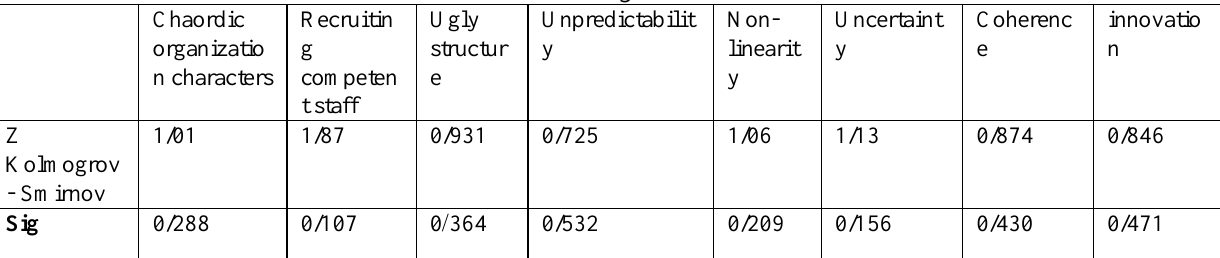
The results of Kolmogrov- Smirnov